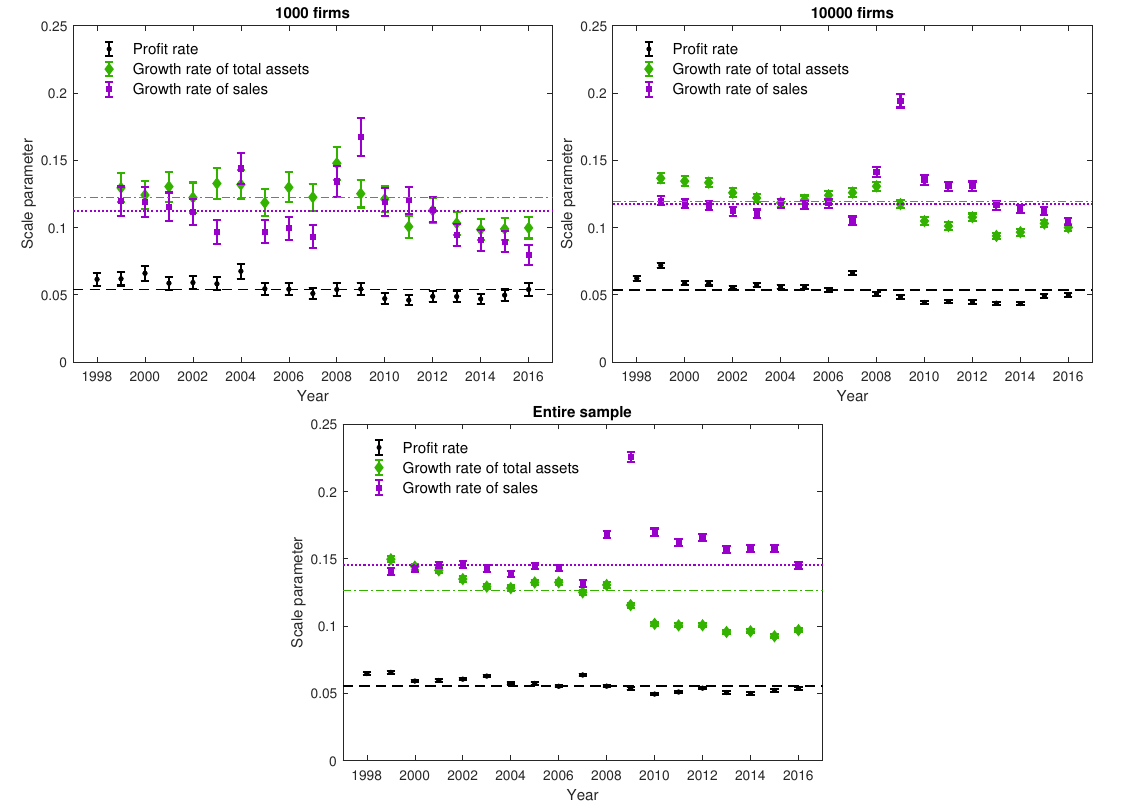
Figure 6. Estimates of the scale parameter of the Subbotin distribution for profit rates, growth of total assets and sales. Error bars show two standard errors. Results refer to the largest long-lived firms of our sample according to their sales in 2016. The dashed line (profit), dotted line (sales) and dashed line with dots (total assets) in the scale parameter figure represent the median of the